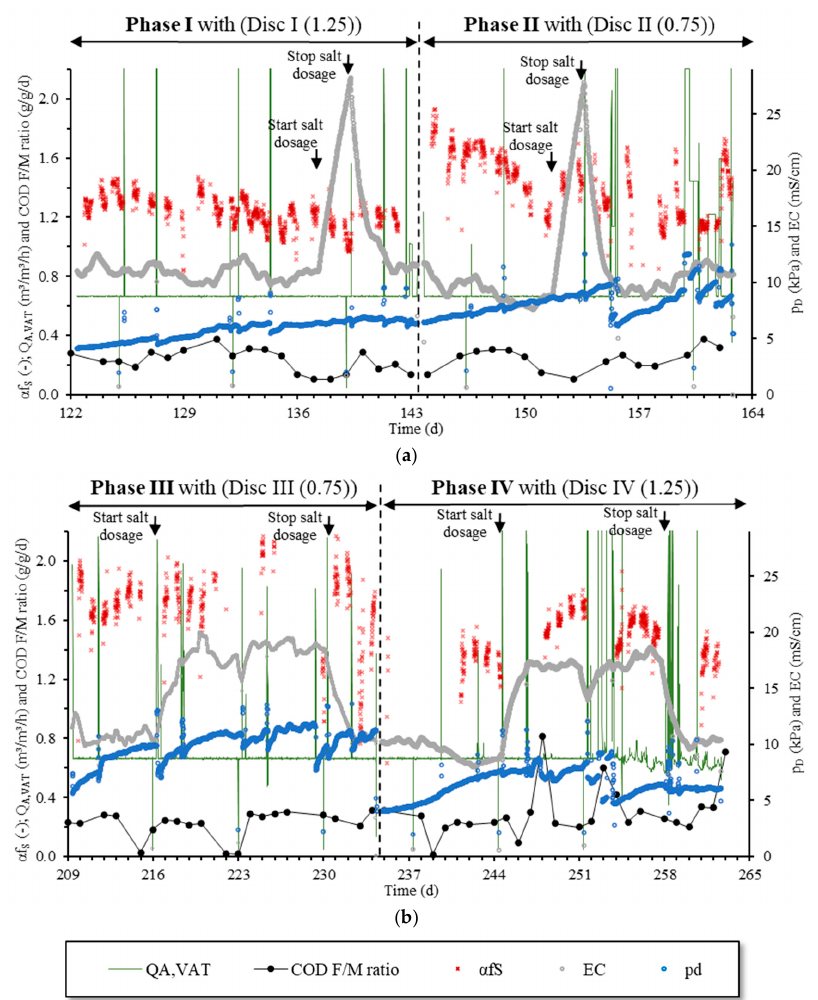
Figure 7. ( a ) Q A,VAT , α f S , EC and p d as 15 min averages and the COD F/M ratio as 24 h for Phase I and II ( b ) and Phase III and IV. II ( b ) and Phase III and